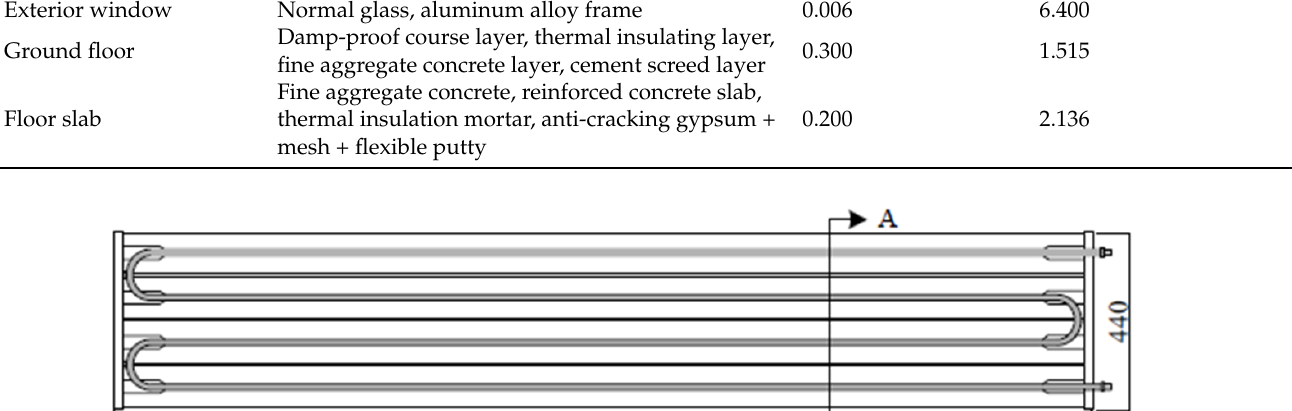
Figure 2. Radiant unit.